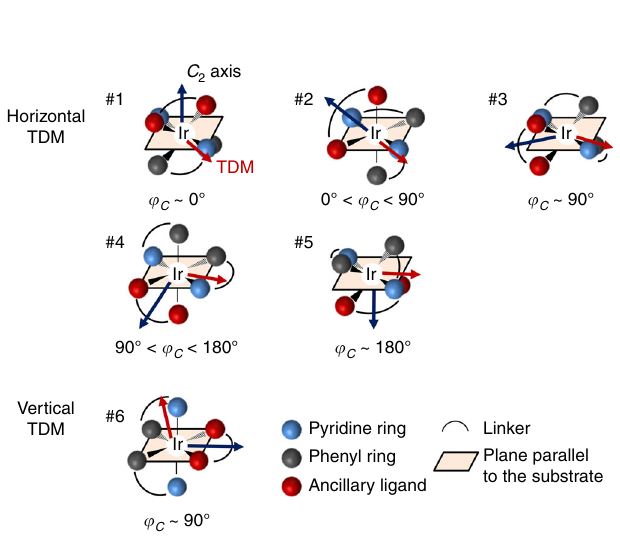
Table 1 Comparison of simulated and measured